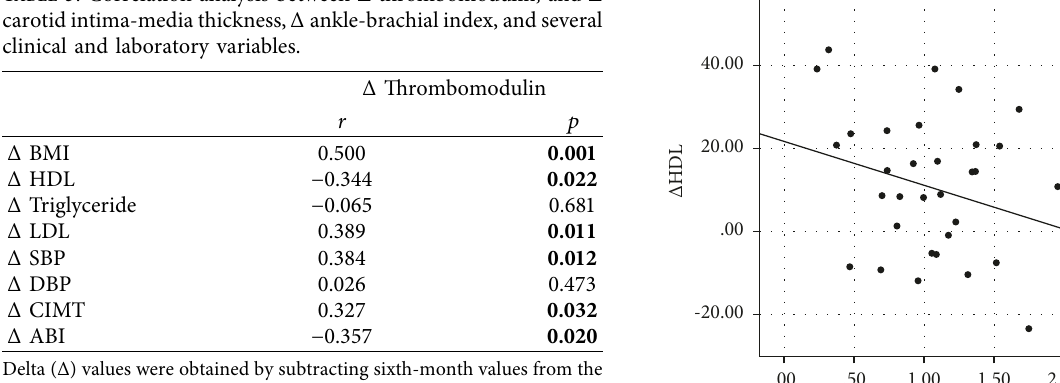
Table 3: Correlation analysis between